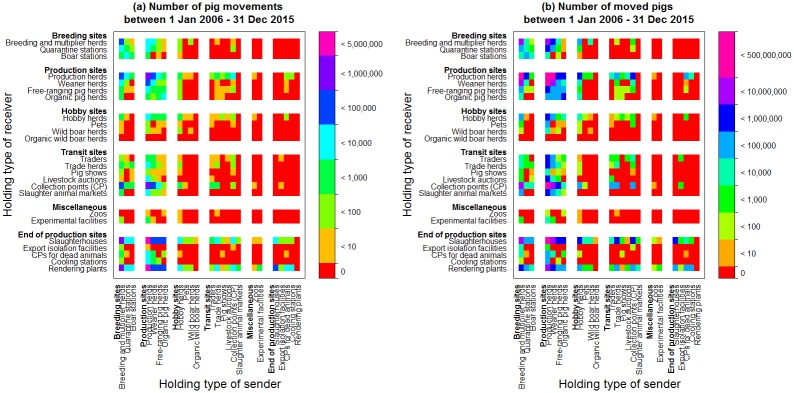
Registered pig movements and number of pigs moved.Heat maps describing (a) the number of registered pig movements and (b) the number of pigs moved between holding types from 1st January 2006 and 31st December 2015 in Denmark. The heat maps show stability over time and for the number of movements (data not shown).